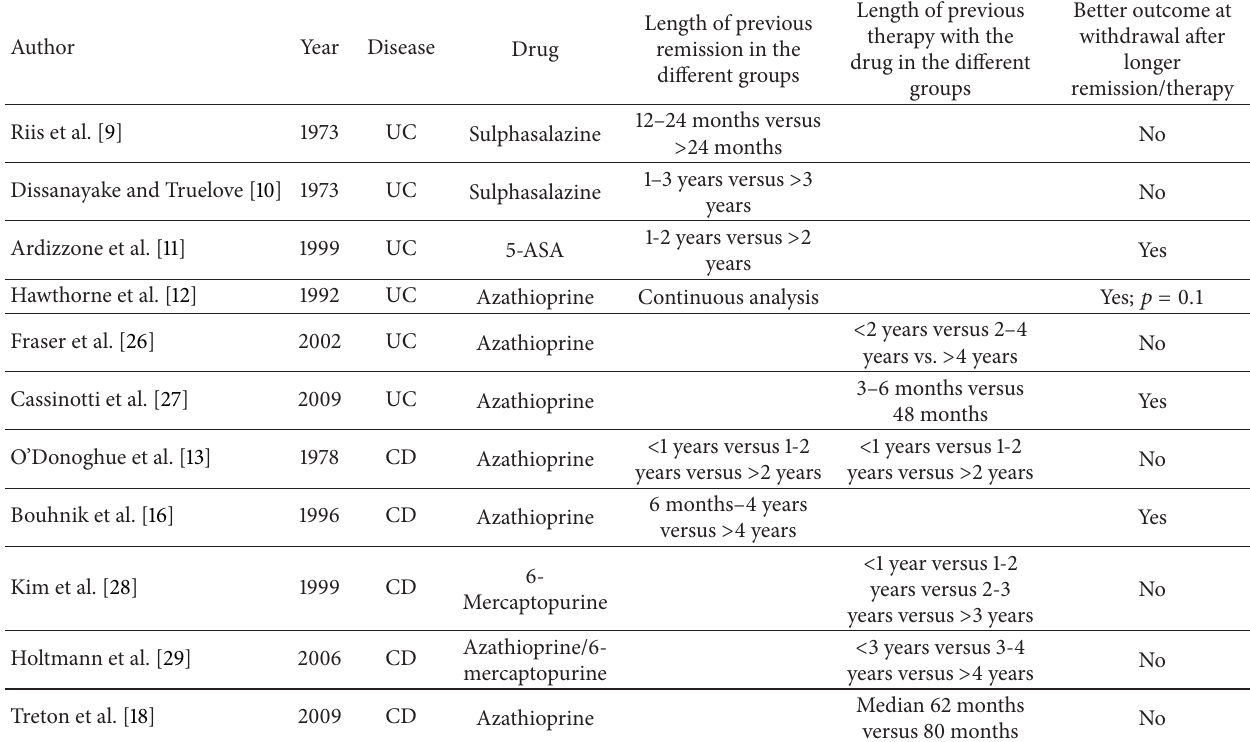
Table 4: The influence of the duration of remission or previous therapy on the outcome after drug